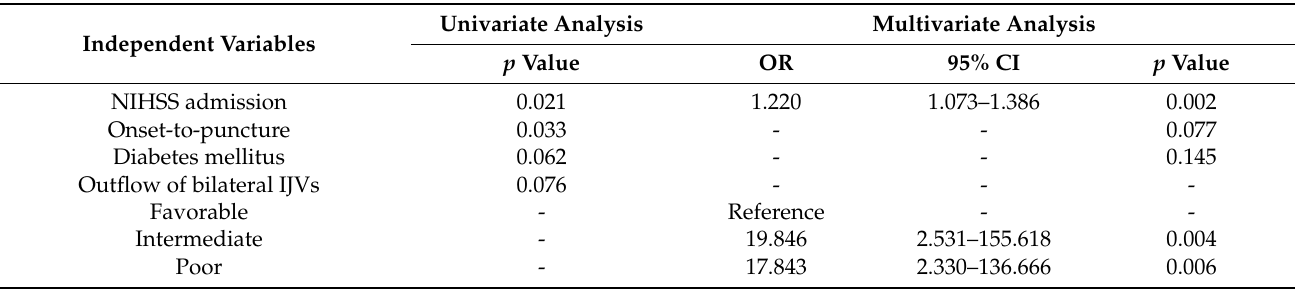
Figure 2. Association between imaging and clinical outcomes and the outflow of bilateral internal jugular veins (IJVs). Patients with a favorable outflow of bilateral IJVs were less likely to undergo hemorrhagic transformation (HT) ( A ), symptomatic intracranial hemorrhage (sICH) ( B ), severe midline shift ( C ), and poor functional outcome ( D ). Table 4. Multivariable logistic regression analysis to predict poor clinical outcome (mRS score of ≥ 3) in the study cohort.